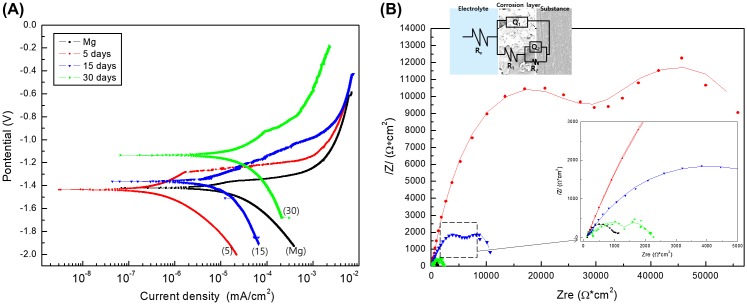
(A) Potentiodynamic polarization curves and (B) Nyquist plots of electrochemical impedance spectroscopy data after immersion for 5, 15 and 30 days in EBSS.